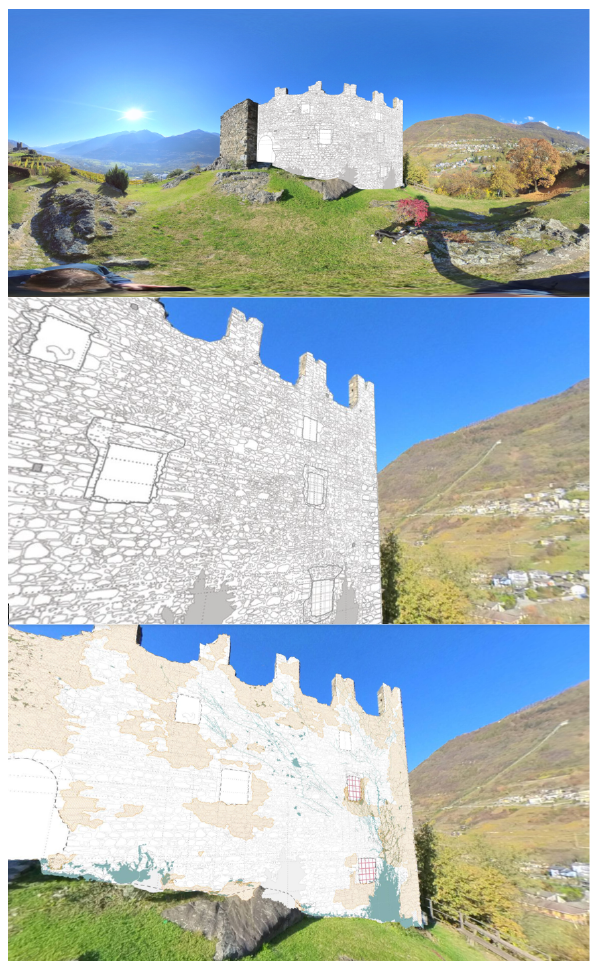
Figure 9: Examples of 2D CAD deliverables projected onto the equirectangular projection: CAD elevation (middle) and condi- tion assessment map (bottom). The image on top shows the orig- inal equirectangular projection with the CAD elevation.